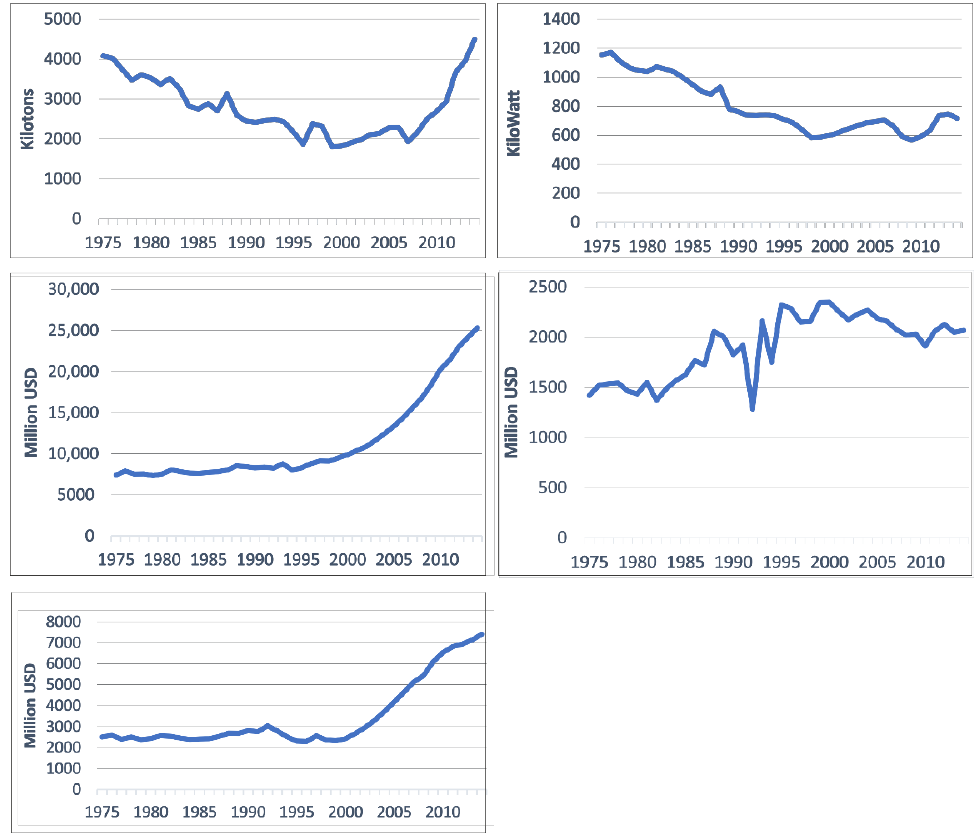
Figure A1. Variables used for the econometric analysis in this study: ( a ) CO 2 emissions; ( b ) electricity consumption; ( c ) GDP constant 2010 prices; ( d ) agriculture; ( e ) industry. Source: World Bank (2021).